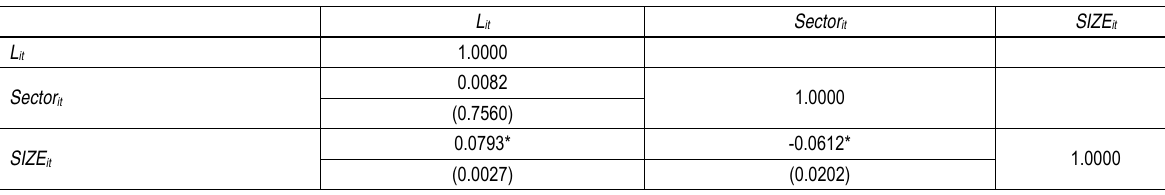
Table 7. Correlation matrix, Model IV